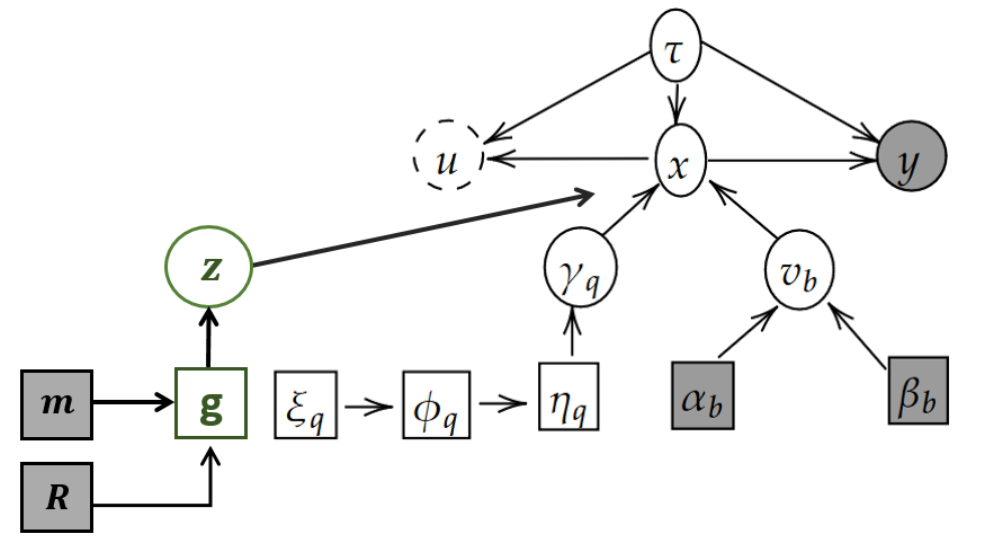
Figure 2. Generative graph of the proposed hierarchical model: variables in boxes denote prior hperparameters, green box and circle are additional parameters for spike-and-slab models, colored boxes and circles denote known variables, and dashed circle denotes an auxiliary variable added to the model for computational